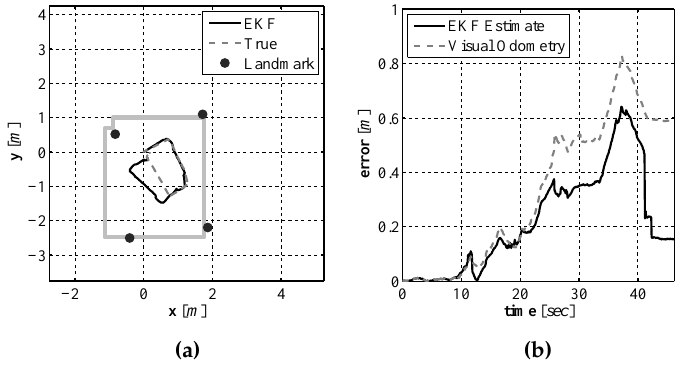
Figure 23. The EKF SLAM produced path and map estimate ( a ) and the error in the position estimate over time ( b ).